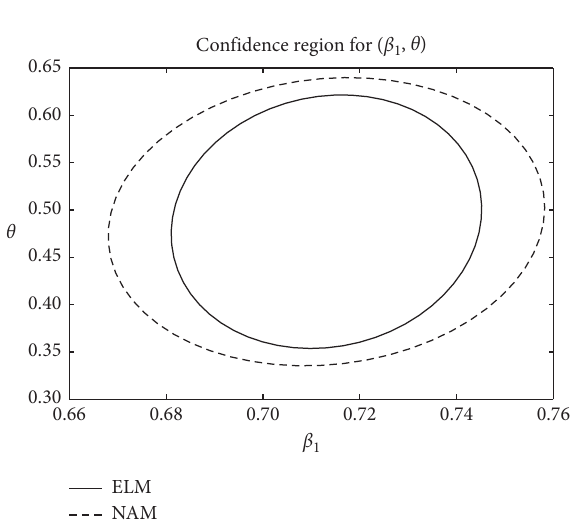
, θ ) of Model (21) with the confidence level of 0.95. 1